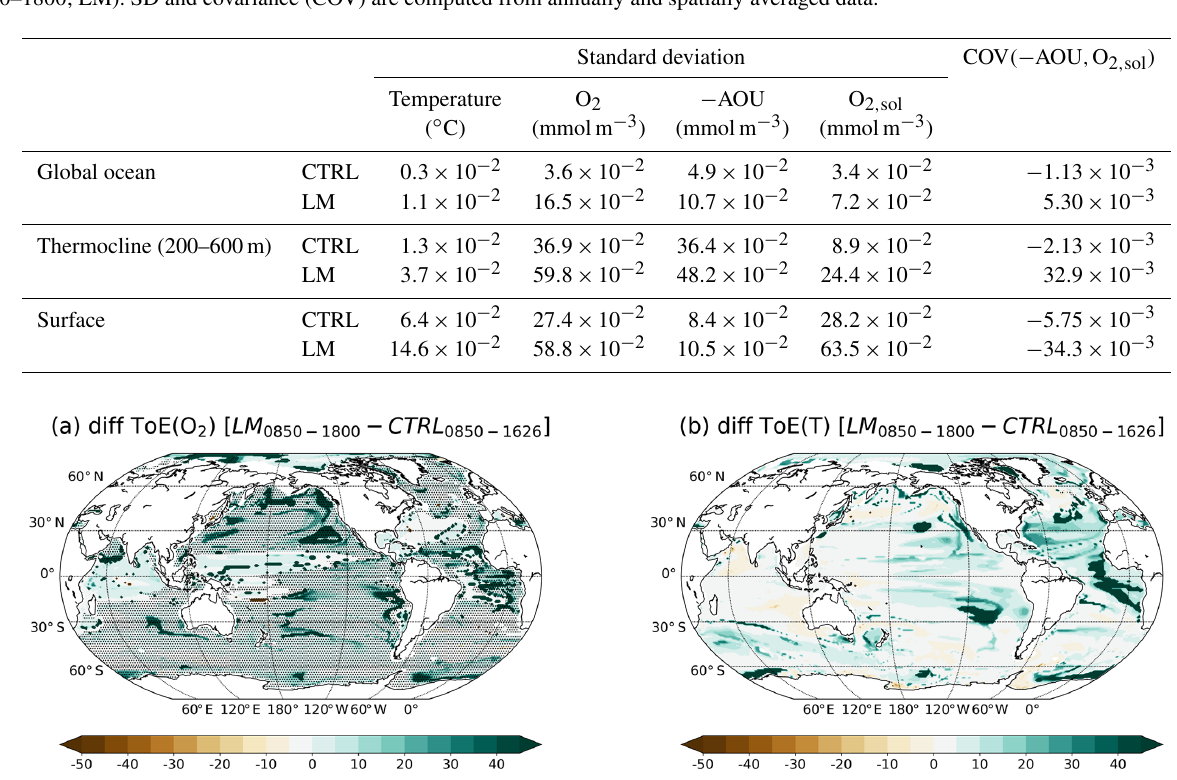
Table 1. Overview of the standard deviations of T , O 2 , O 2 , sol and − AOU, and the corresponding covariance between − AOU and O 2 , sol for the global mean ocean, the thermocline (200–600m) and the surface ocean for the control simulation (CTRL) and the forced simulation (850–1800; LM). SD and covariance (COV) are computed from annually and spatially averaged data.